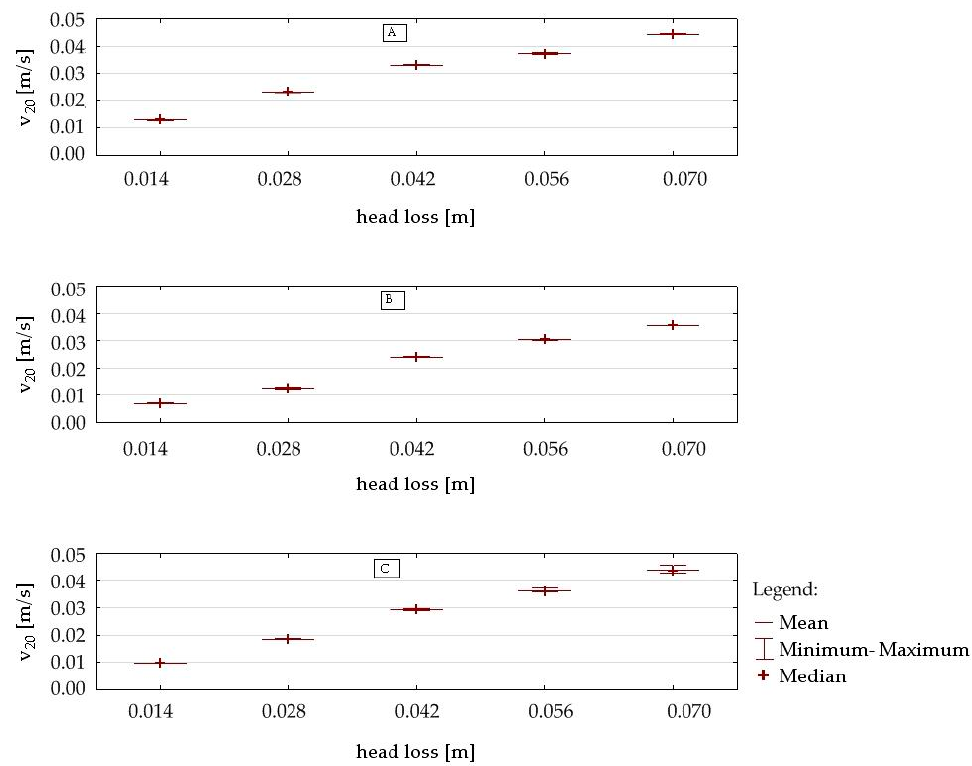
Figure 5. Statistical flow velocity characteristics for the tested nonwoven geotextiles.